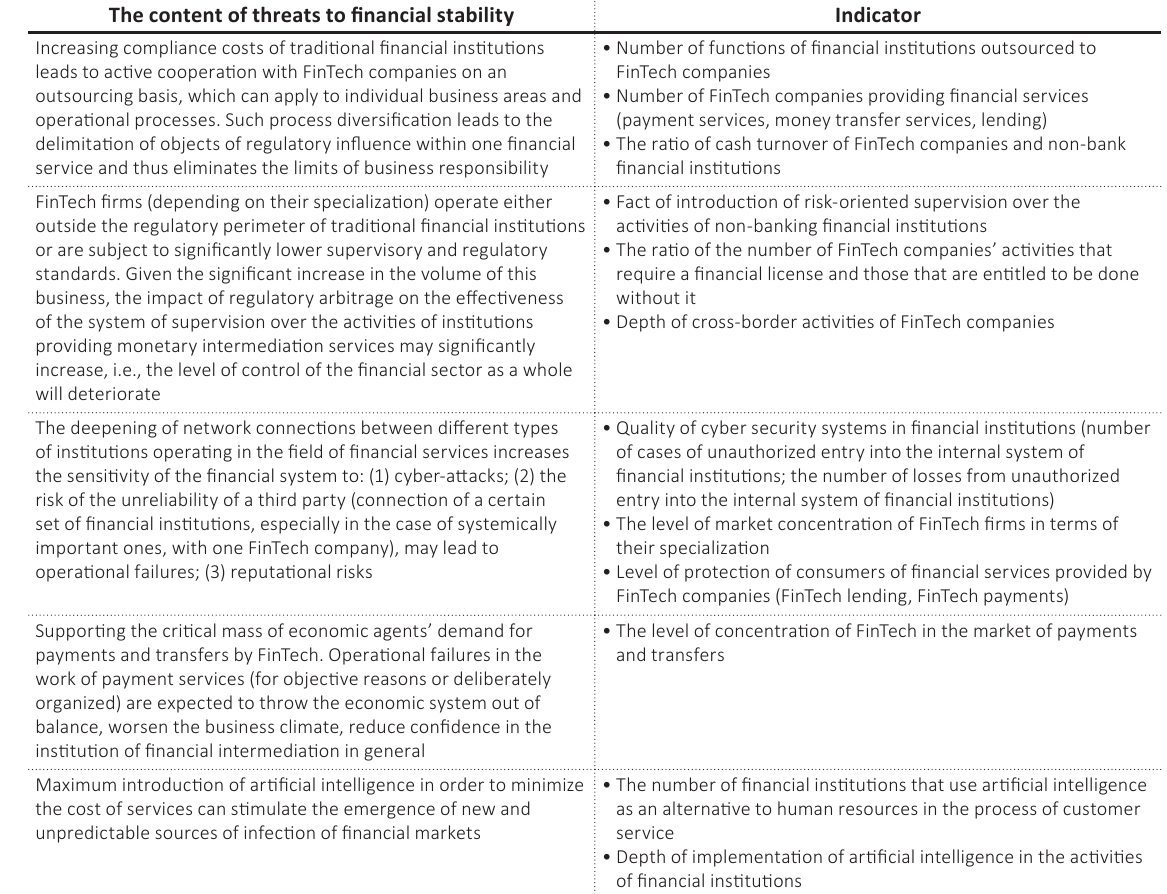
Table 5. Potential threats and indicators for monitoring the importance of FinTech development in the context of ensuring financial stability of the financial